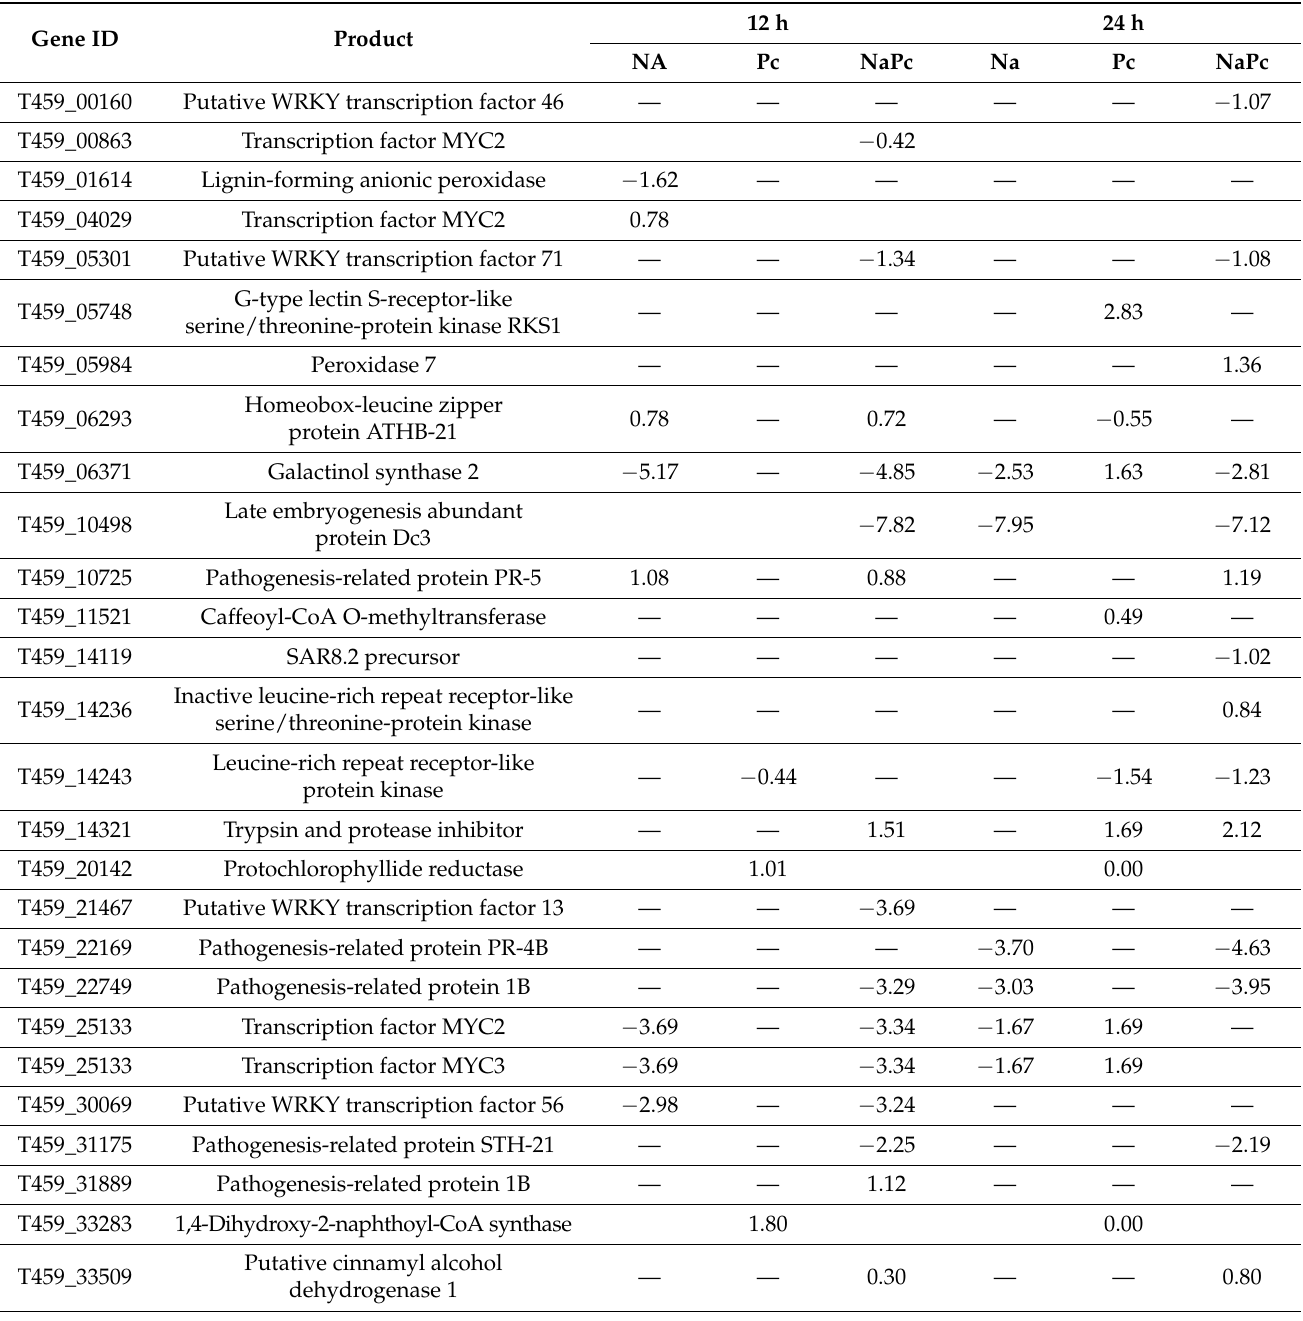
Table 1. Defense response-related genes expressed differentially with the treatments. Log2 fold change gene expression of upregulated (green) and downregulated (red) genes. Genes with no significant differential expression (when p > 0.01) were indicated with a dash